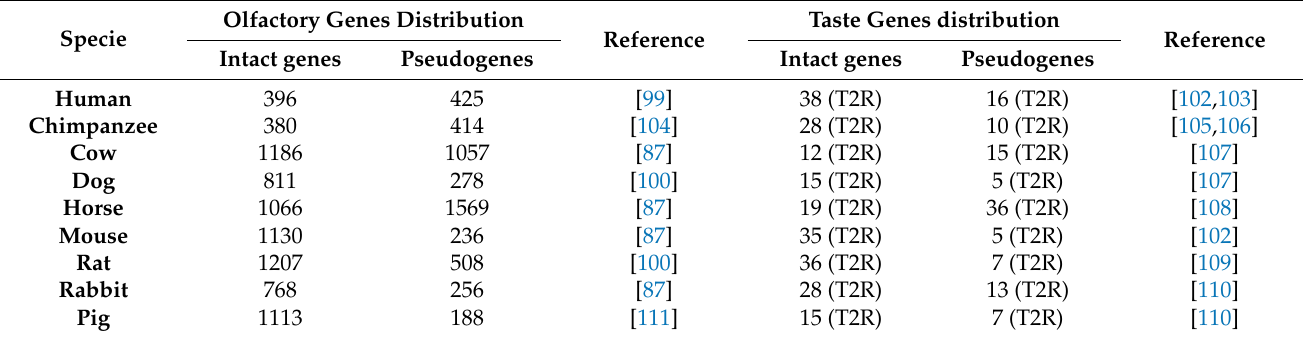
Table 2. The number of odorant and taste receptor genes in different